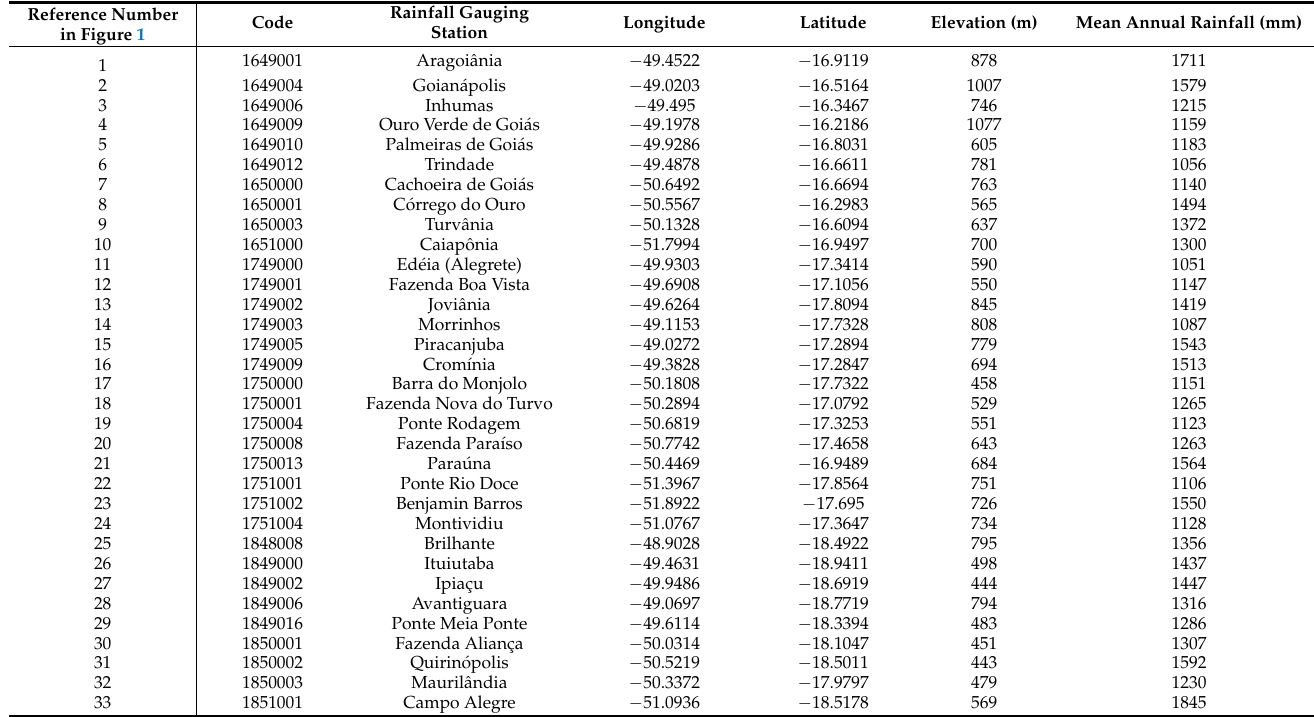
Table 1. Rainfall gauging stations utilized for the estimation of spatialized precipitation and for comparison with the GPM